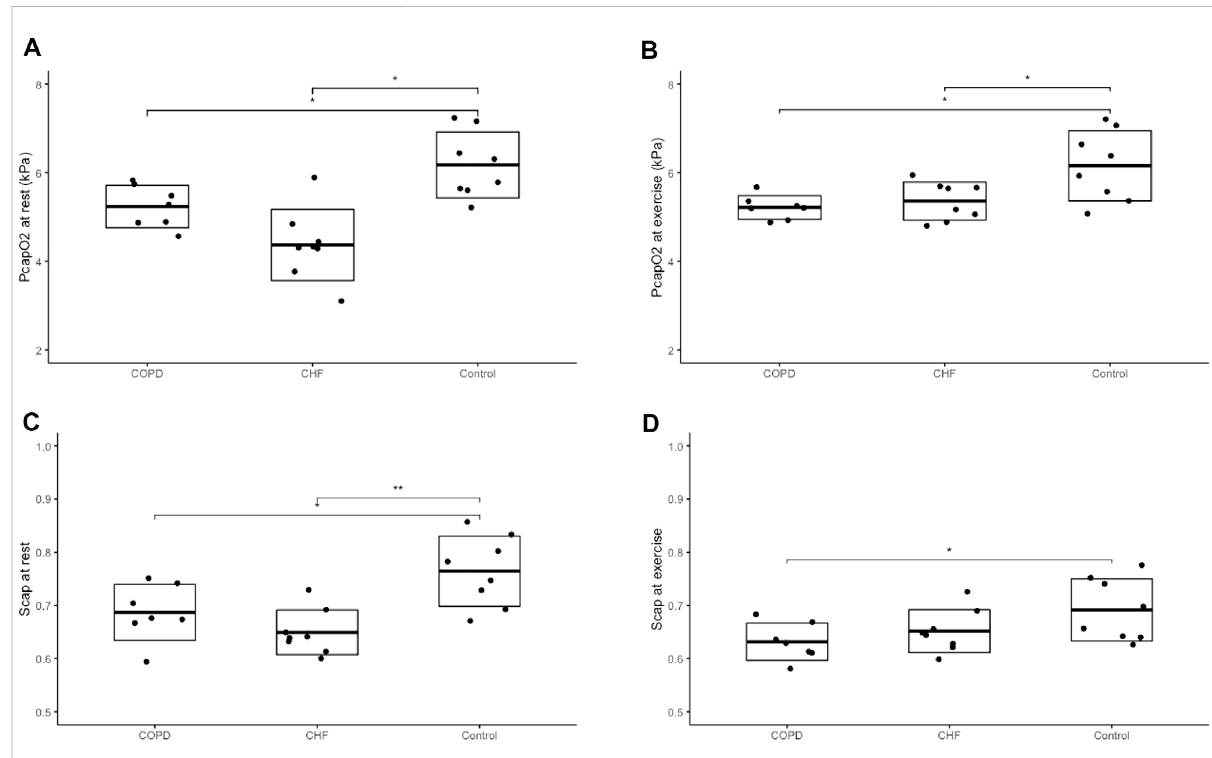
FIGURE 2 Capillary oxygen tension and saturation Panel (A) shows the capillary oxygen tension (PcapO 2 ) at rest, panel (B) the capillary oxygen tension during one leg knee-extensor exercise, panel (C) the oxygen saturation (Scap) at rest and panel (D) the oxygen saturation during one leg knee- extensorexercise.Weperformedaone-wayANOVAandifsigni fi cant,aTukey ’ shonestsigni fi cantdifferencetestwasusedtoanalysethedifferences betweengroups.Differencebetweengroupsmarkedwitha*=( p < 0.05),**=( p < 0.01),***=( p < 0.001).Dotplotswithboxesshowingmeanand standard deviation with exact values for each participant, marked with a black dot. Chronic heart failure (CHF) participants n=8, Chronic obstructive pulmonary disease (COPD) participants n = 7, healthy control n = 8.